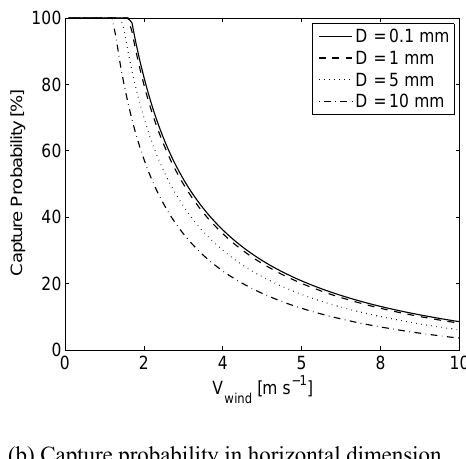
Figure 8. Capture probability of different raindrops in the vertical dimension and horizontal dimension ( T interval = 2ms).